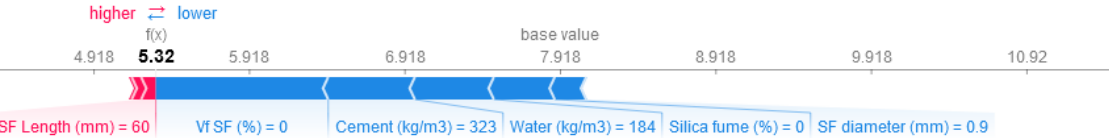
Figure 23. Flexural strength SHAP plot.